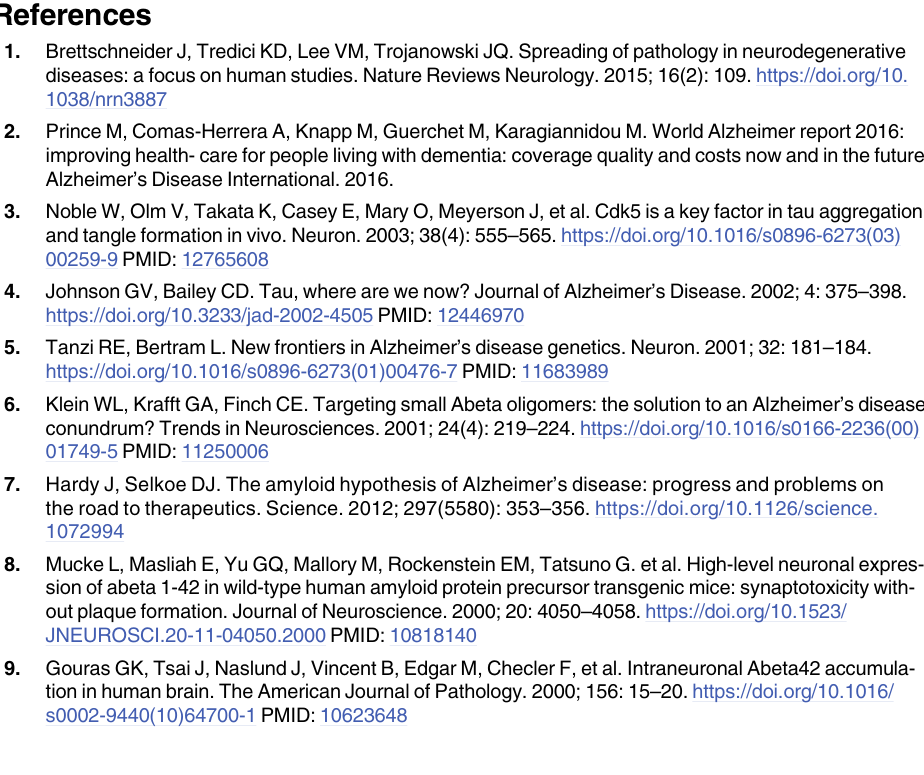
S7 Table. Modules detected trough WGCNA and their correlation with the clinical features in function of threshold values. S8 Table. Results of gene set enrichment analysis of the detected communities in GSE48350 and GSE29378